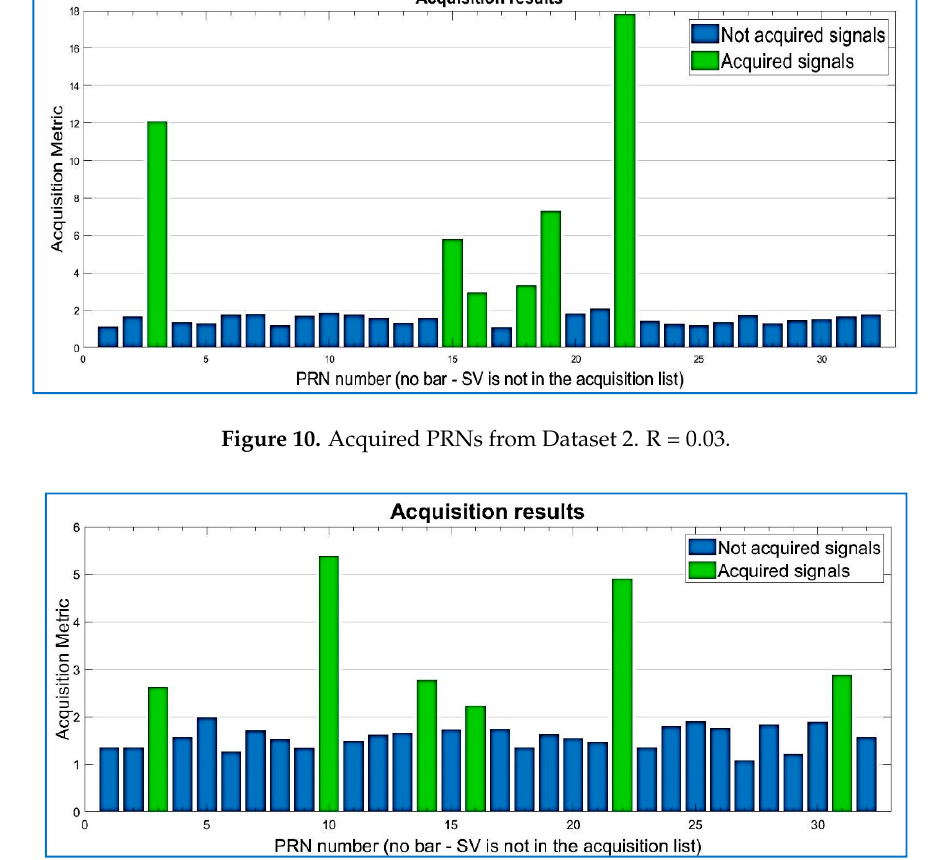
Figure 11. Acquired PRNs from the RTLSDR receiver/Dataset 3. R = 0.30.